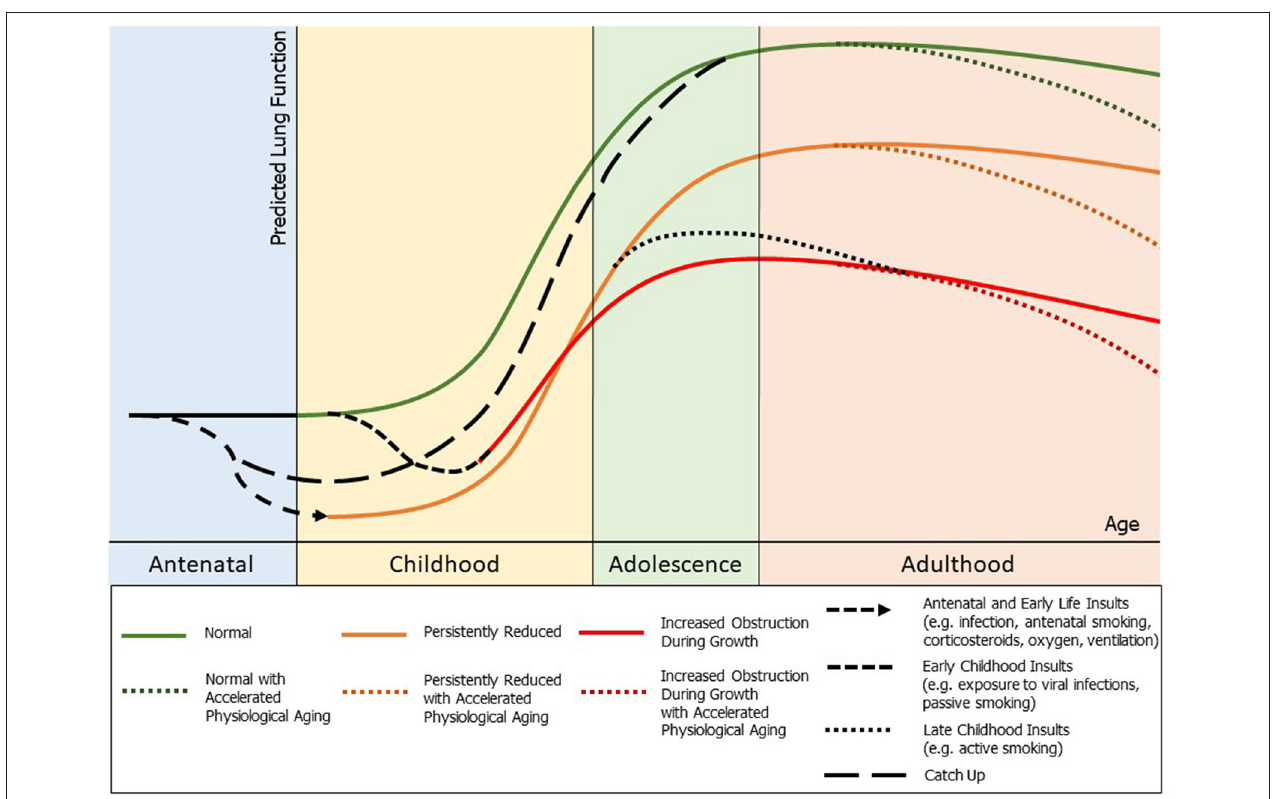
FIGURE 1 | Outline of potential lung function trajectories and lung function perturbations throughout life: normal (green), persistently reduced lung function (orange), and early decline in lung function with increased obstruction during growth (red), with a potential for accelerated physiological aging in adulthood. Potential insults to lung health and their possible impact on lung function throughout life marked. Also noted is a potential for “catch up” growth to normal lung function which may occur during childhood and